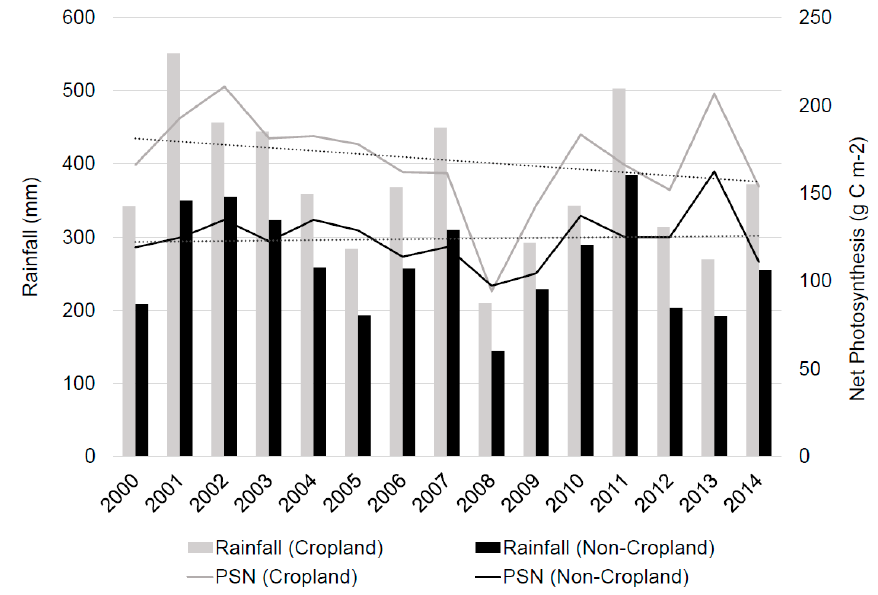
Figure 7. Growing season net photosynthesis (PSN) and rainfall trends in cropland and non-cropland areas between 2000 and 2013.